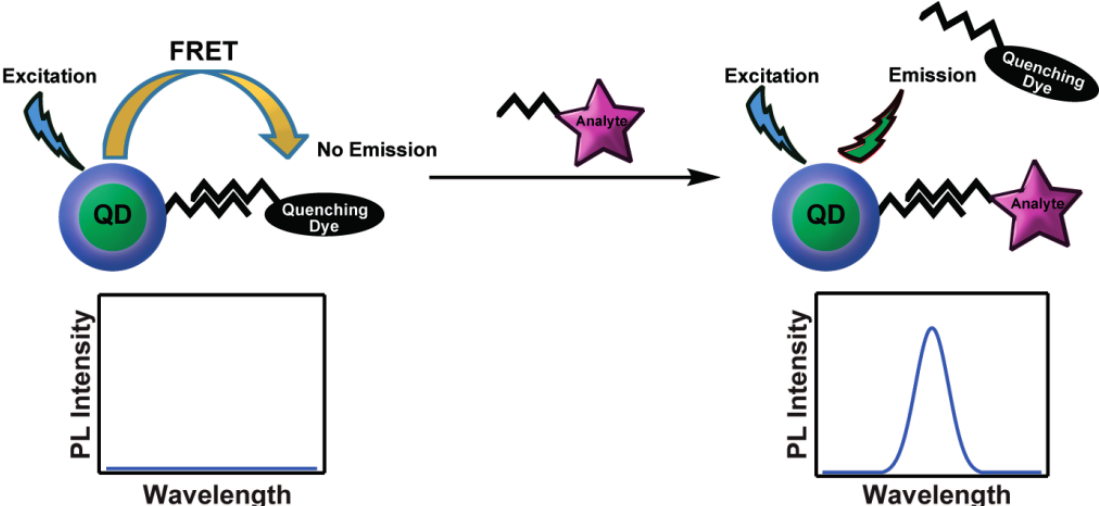
Figure 1. Competitive displacement of a quenching dye by the analyte removes the FRET interaction, resulting in QD emission